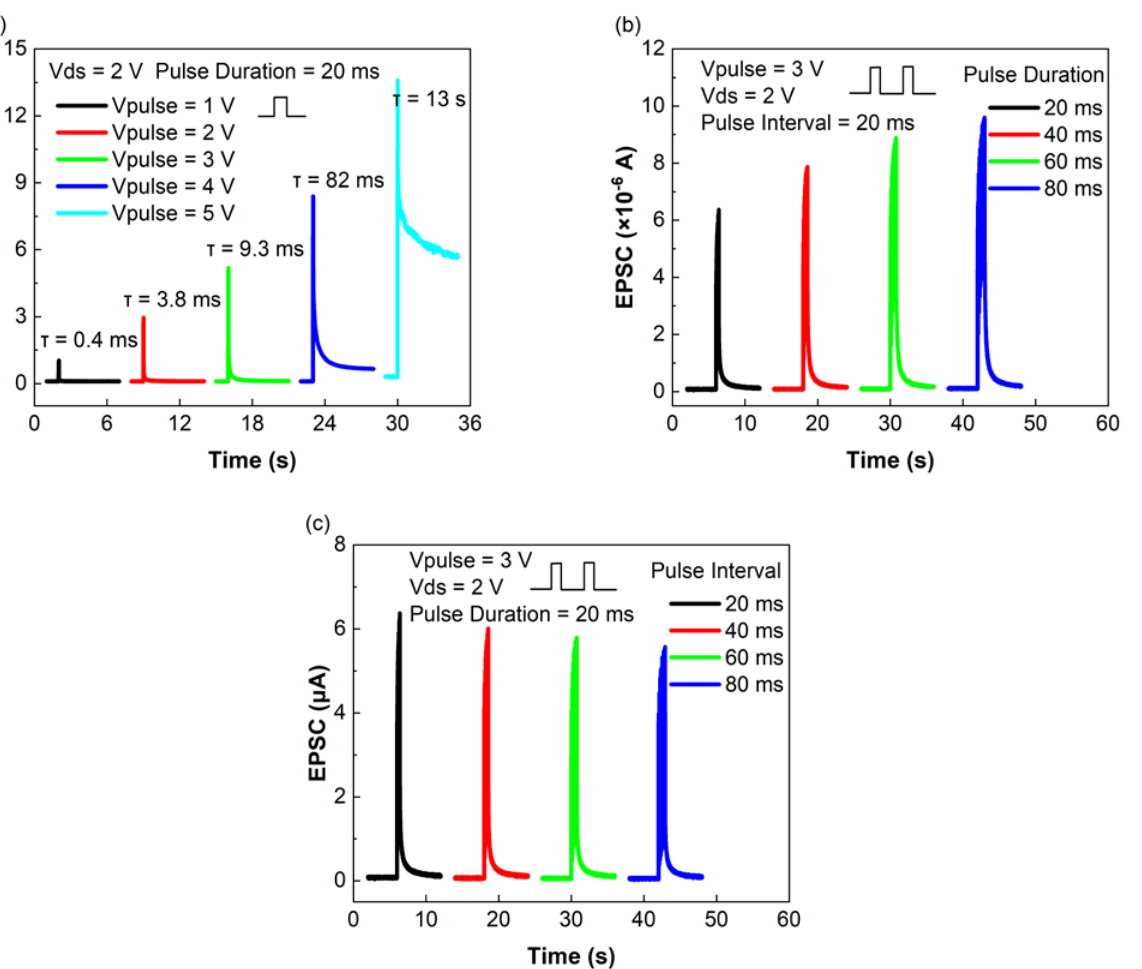
Figure 5. Excitatory postsynaptic current (EPSC) curves of the AlO x /InO x EDLT with a planar gate controlled by ( a ) single pulse with various amplitudes, ( b ) 10 consecutive pulses with various durations, and ( c ) 10 consecutive pulses with various intervals.